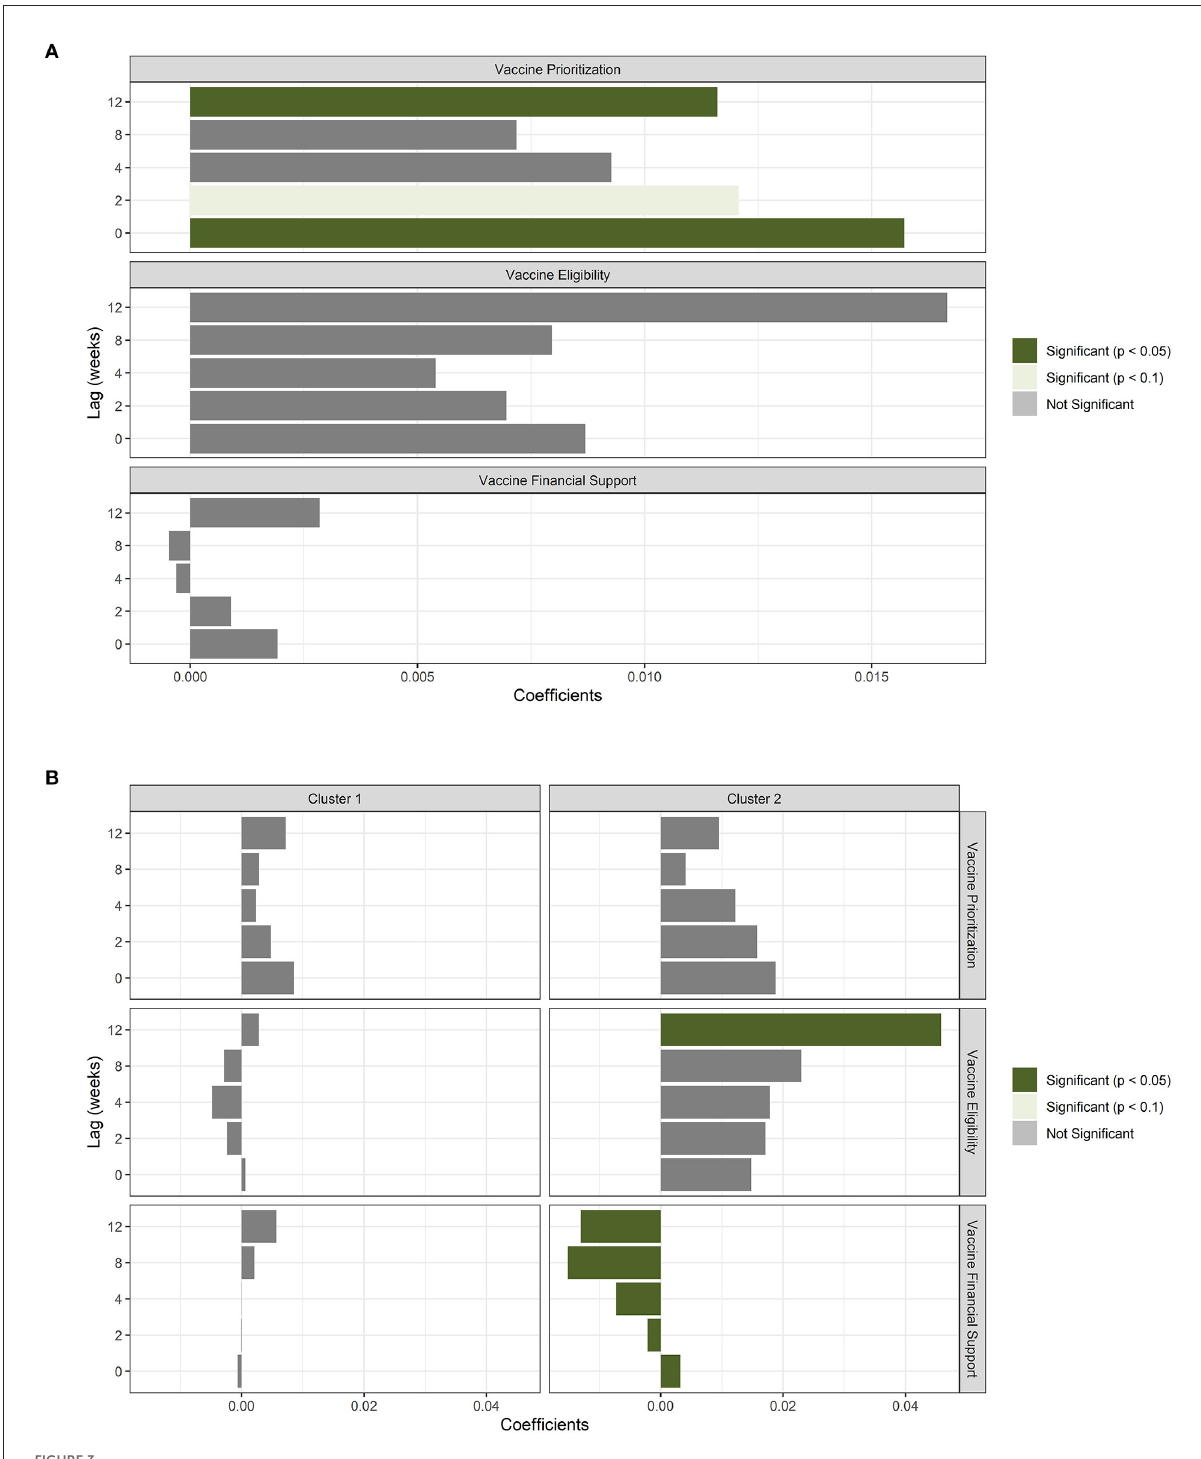
FIGURE3 Vaccine policy results in lagging. (A) Results from the analysis of vaccine policies using all countries. (B) Results from the analysis of vaccine policies for cluster groups of